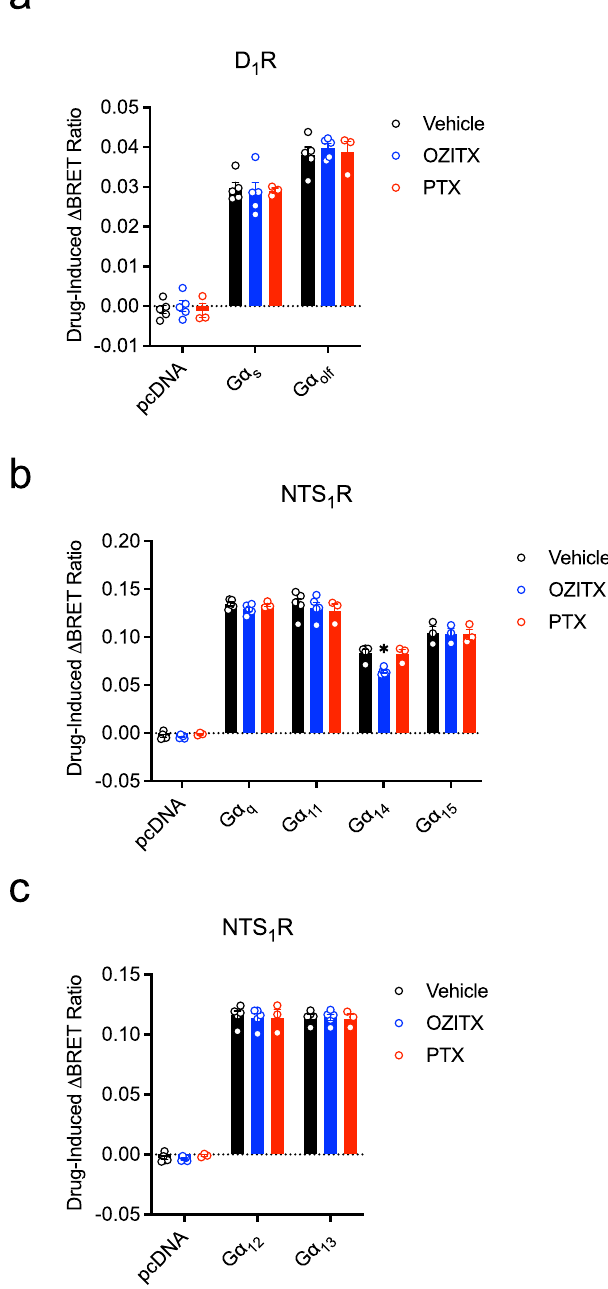
Fig. 3 G α s, G α q and G α 12 subfamily activation in presence of OZITX and PTX. a Activation of G α s subfamily members by the dopamine D 1 receptor (D 1 R) in the presence of OZITX and PTX. b Activation of G α q subfamily members by NTS 1 R in the presence of OZITX and PTX. c Activation of G α 12 subfamily members by the neurotensin receptor 1 (NTS 1 R) in the presence of OZITX and PTX. HEK 293 Δ G α -all CRISPR cells were transfected with cDNA encoding the particular GPCR and G α together with the G-protein activation sensors as described in “ Methods ” . The cells were pre-treated with either vehicle (black), OZITX (blue) or PTX (red) for 24 h before stimulation with the agonists 100 nM SKF83822 (D 1 R)/1 μ M NT8-13 (NTS 1 R) for 2.5 min followed by BRET detection. The data are represented as the mean drug-induced increase in BRET ratio from vehicle control ± SEM from three separate experiments. *Represents where the OZITX or PTX-treated condition is signi fi cantly different ( P < 0.001) from the vehicle-treated condition (black) as determined by a one-way ANOVA with Dunnett ’ s multiple comparisons